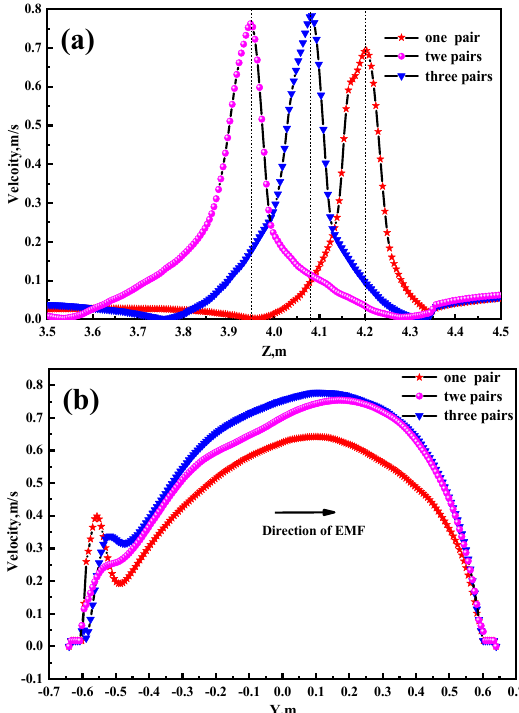
Figure 9. Distribution of velocity with different numbers of rollers ( a ) along the centerline in the casting direction, and ( b ) along the centerline of the rollers in the wide direction.